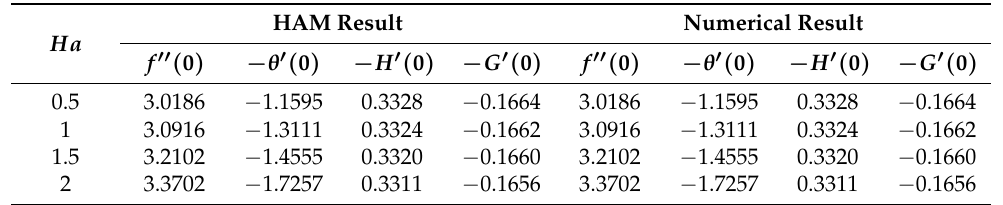
Table 5. Computational for f (cid:48)(cid:48) ( 0 ) , − θ (cid:48) ( 0 ) , − H (cid:48) ( 0 ) and − G (cid:48) ( 0 ) with S = − 0.5, P r = R = Sc = K 1 = K 2 = 0.5, L = δ = 2, Q = 4 and differing values of Ha .